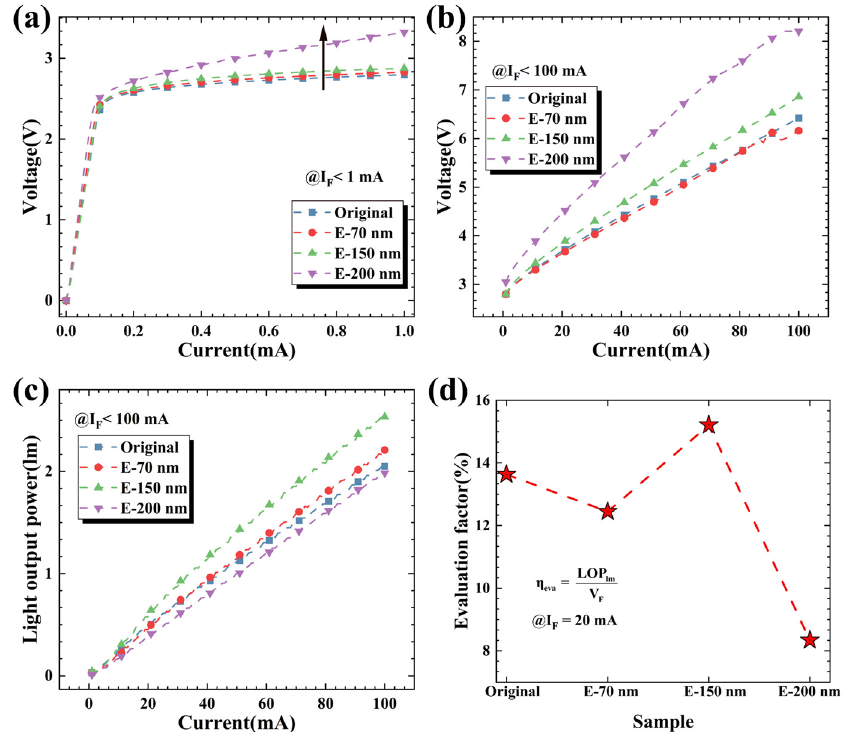
Figure 6. Device tests of the four groups. ( a ) Under the injection current range of 0–1 mA, the turn-on voltage changes; ( b ) under the injection current range of 0–100 mA, the working voltage changes; ( c ) the change in the optical output power under different injection currents; ( d ) comprehensive device efficiency.